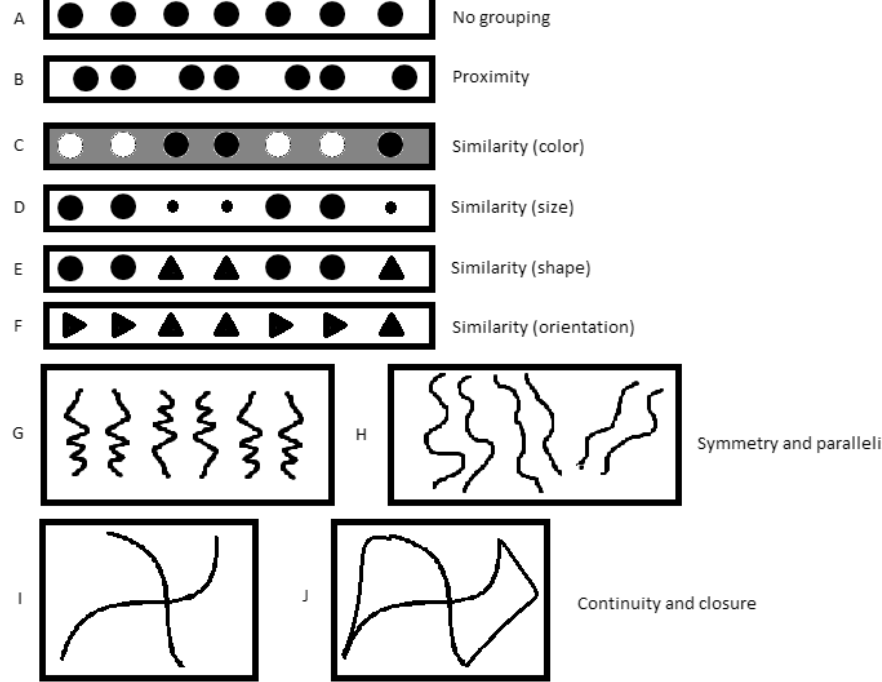
Fig. 1. Classical laws of